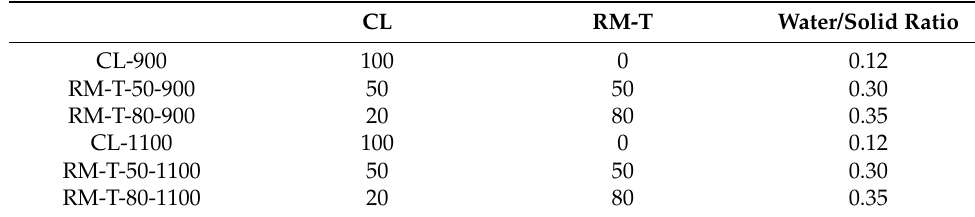
Table 3. Brick compositions (wt%).